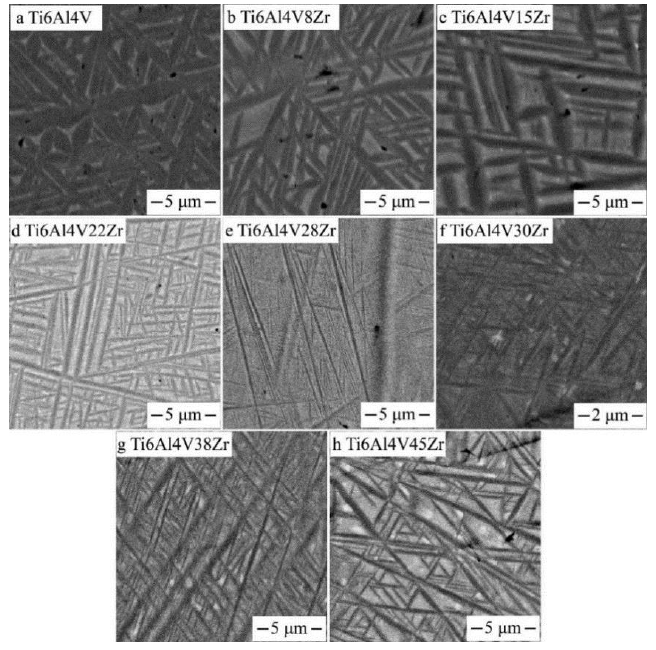
Figure 5. SEM, backscattered electron images of Ti6Al4VxZr alloys after aging at 600 °C taken from the Ti6Al4V – Ti6Al4V45Zr diffusion multiple. The series of SEM micrographs showing the α precipitate morphologies for various Zr contents after aging at 650 °C for 6 h is shown in Figure 6. At 650 °C, the precipitates were coarser and had less volume fraction than in the lower aging temperatures. Moreover, the finest acicular α precipitates appeared in the alloy with compositions of approximately 30 wt.% Zr.